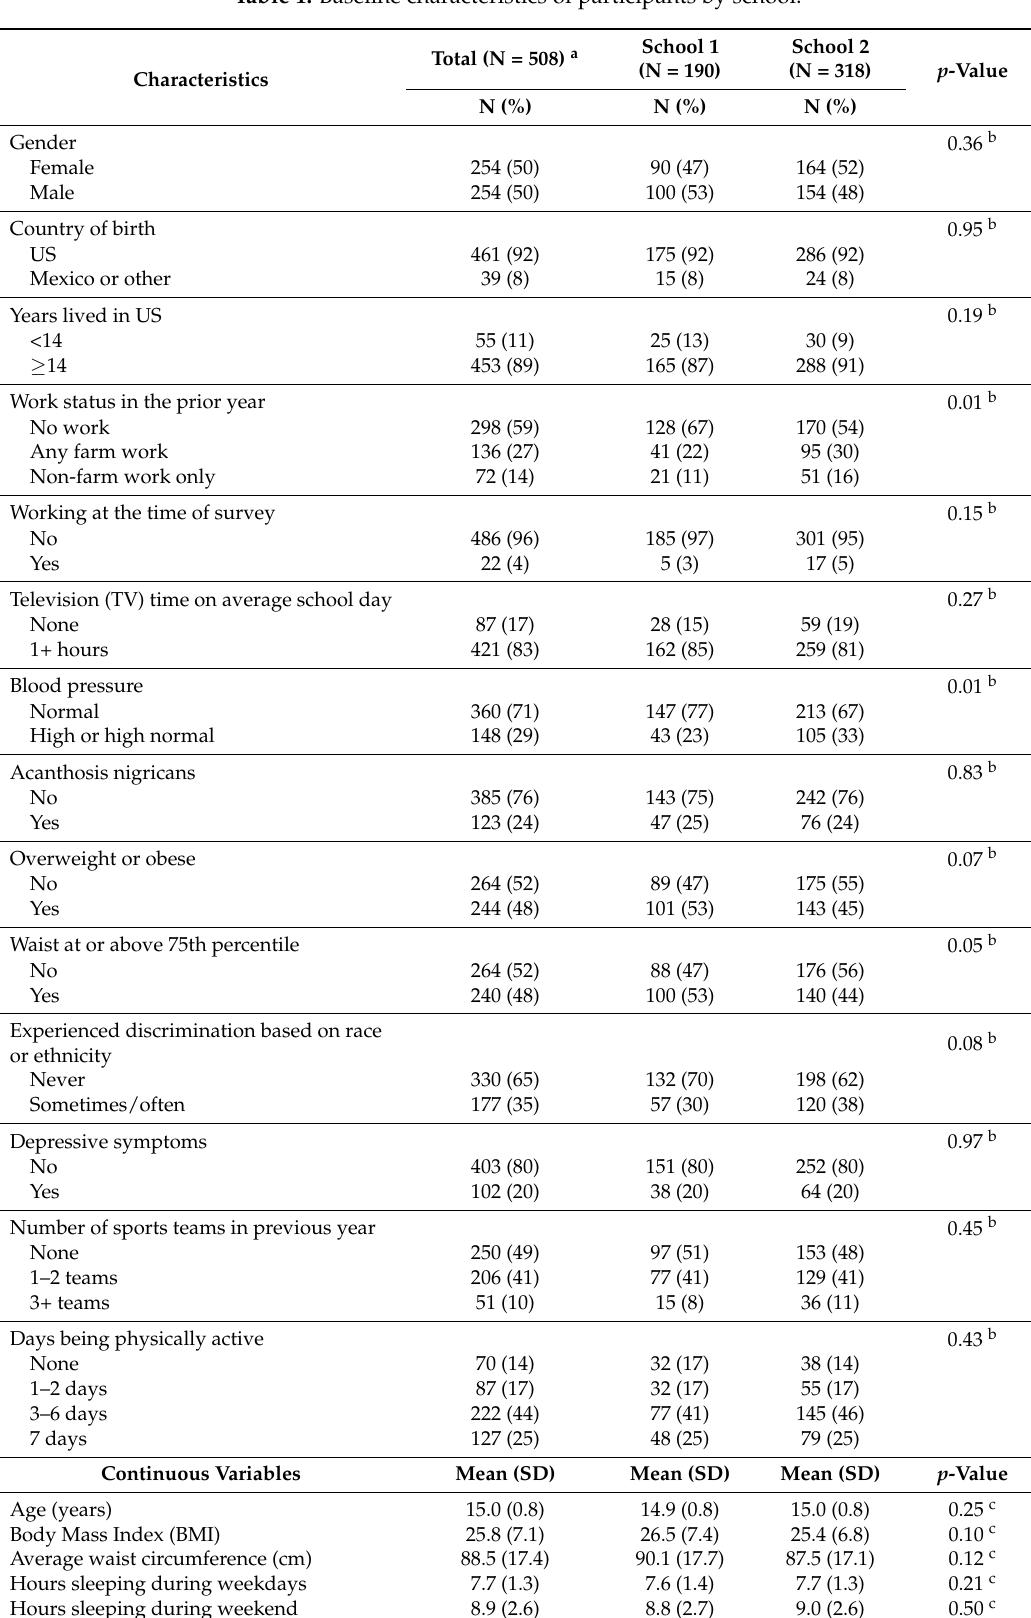
Table 1. Baseline characteristics of participants by